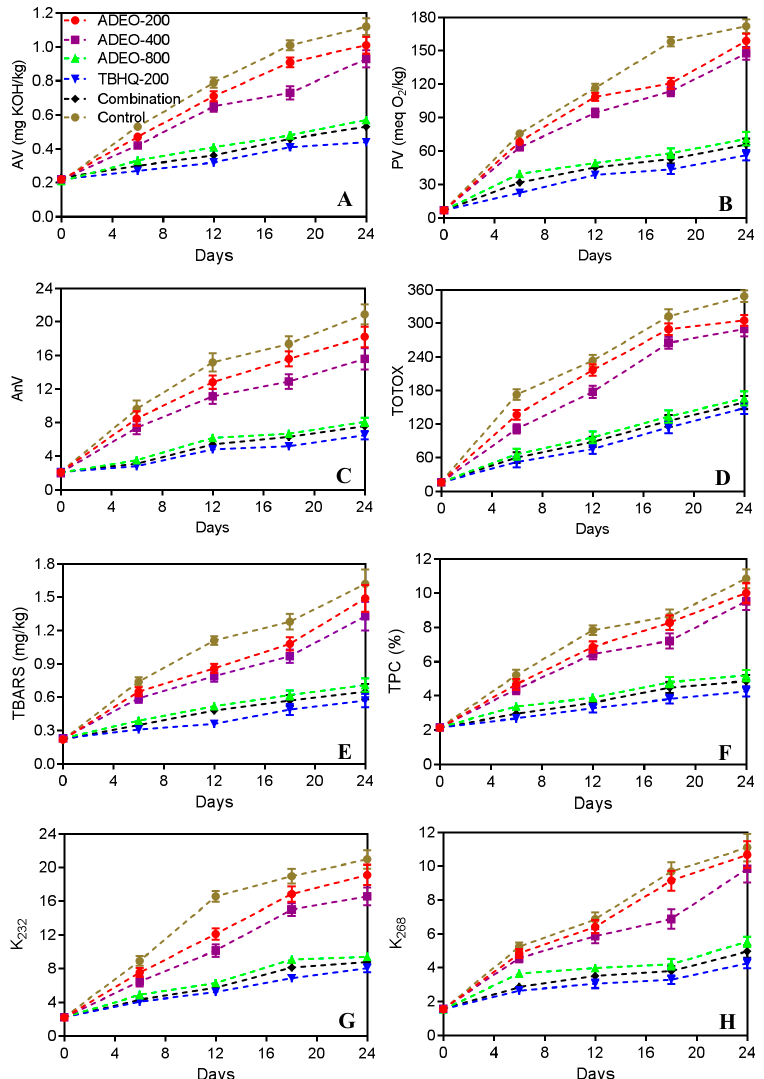
Figure 1. Acid value (AV) ( A ), peroxide value (PV) ( B ), p -anisidine value (AnV) ( C ), total oxidation value (TOTOX) ( D ), thiobarbituric acid reactive substances (TBARS) ( E ), total polar compounds (TPC) ( F ), K 232 ( G ), and K 268 ( H ) of sunflower oil samples in the high-temperature storage influenced by ADEO.